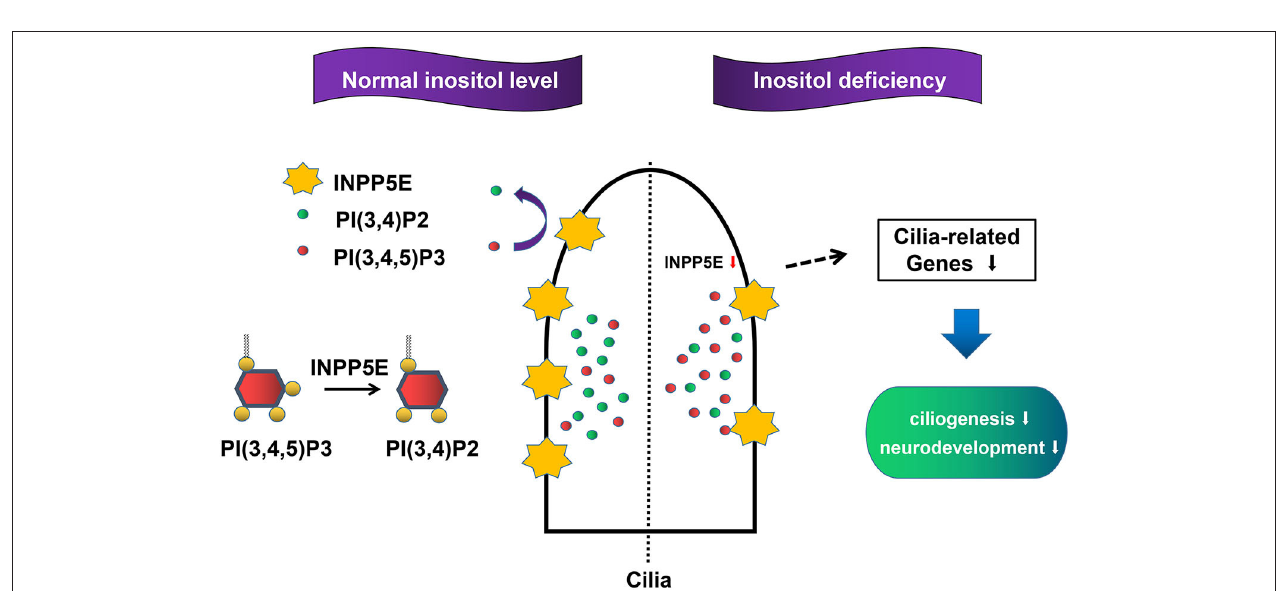
FIGURE 9 | Proposed model for the role Inpp5e in ciliogenesis through phosphoinositide under inositol deficiency.